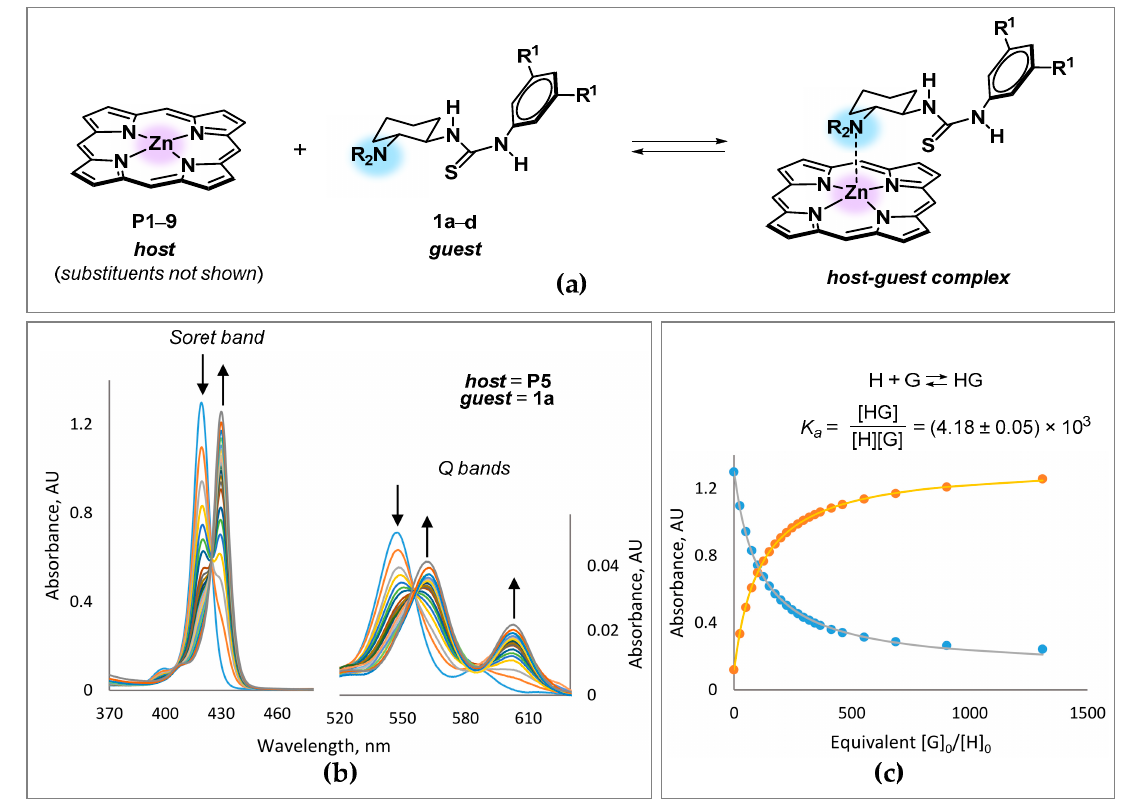
Figure 3. ( a ) Schematic representation of the complexation process of zinc porphyrins (substituents not shown) with 2-aminocyclohexyl arylthioureas; ( b ) representative UV-Vis spectroscopic titration (measured in CH 2 Cl 2 ) of P5 with 1a : addition of 1a (0–2.8 × 10 − 3 M) causes bathochromic shifts of the porphyrin Soret band and Q bands (enlarged, 3 × ); ( c ) representative 1:1 binding isotherm for the same P5 - 1a host–guest system. The complete datasets for all studied host–guest pairs are provided in the Supplementary Material.